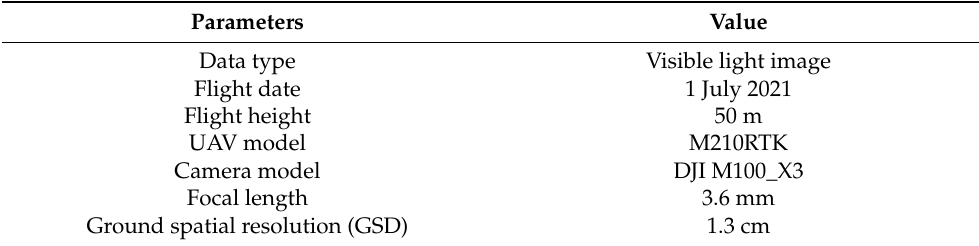
Table 1. UAV image data parameter